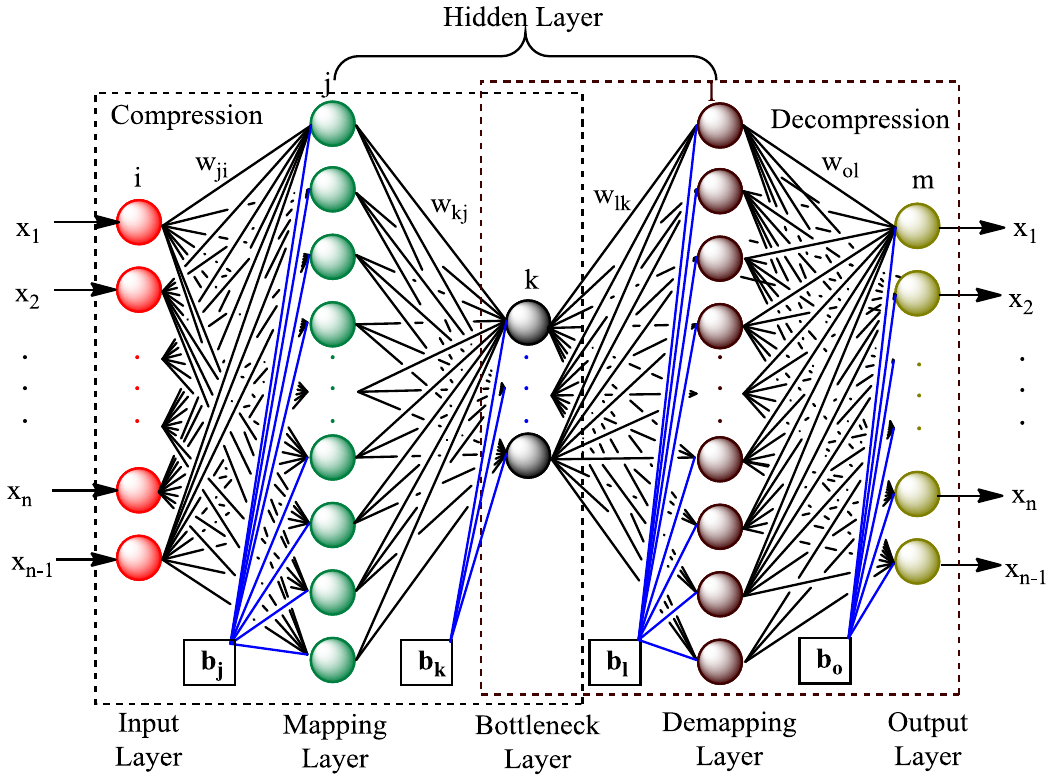
Figure 8. General architecture of autoassociative neural networks (AANN).